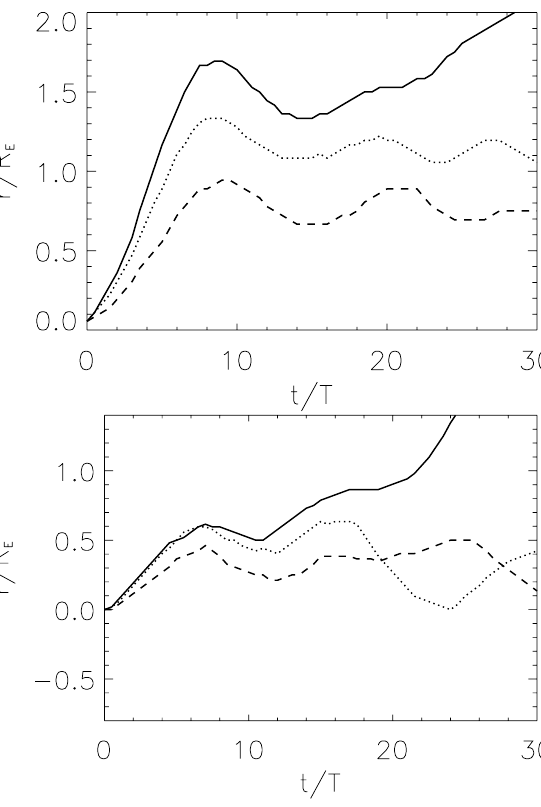
Fig. 13. Figures corresponding to Figs. 9 (top) and 10